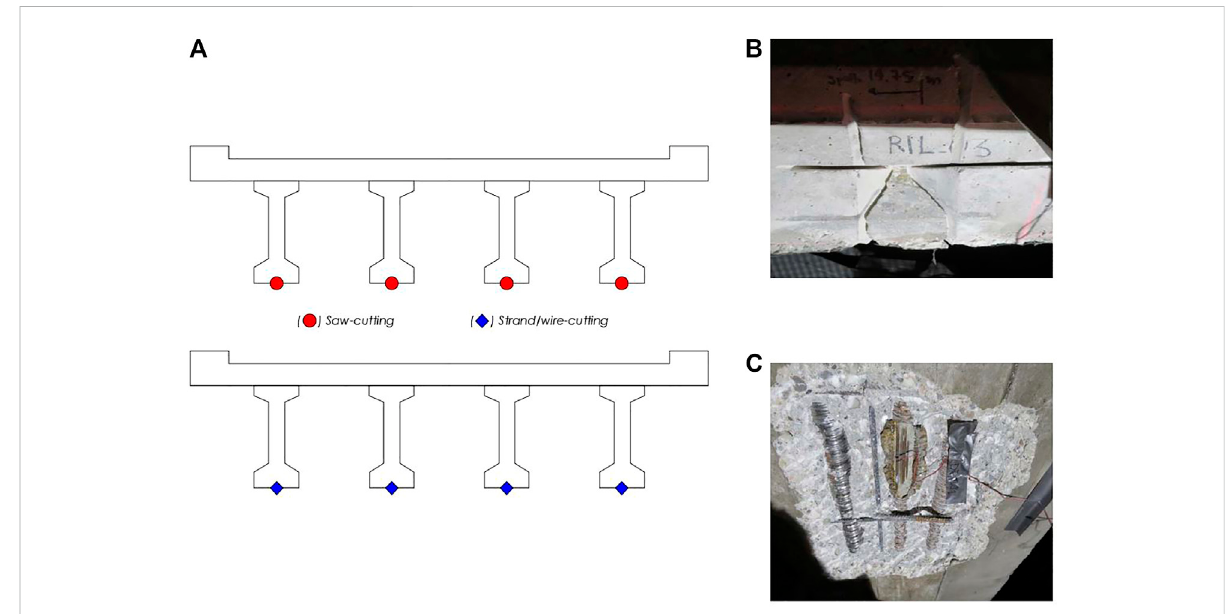
FIGURE 11 Stress-release method with saw-cut and wire-cut: location of test points (A) , saw-cuts (B) , and wire-cuts (C) .